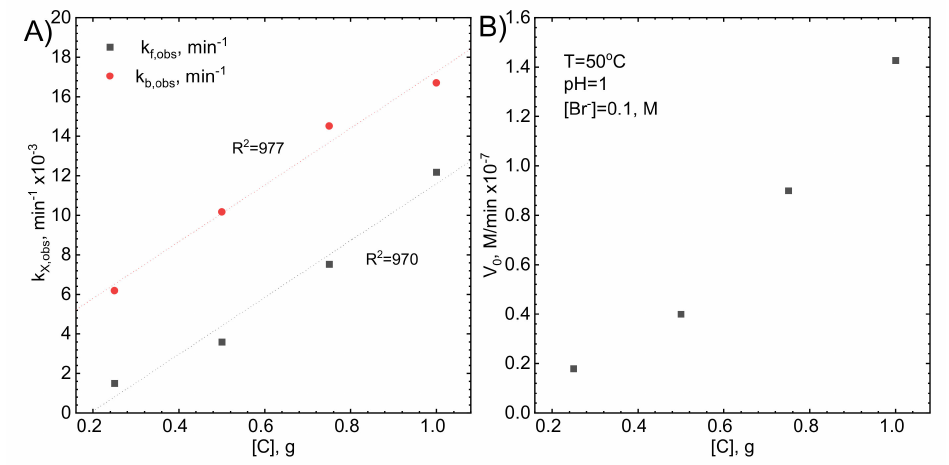
Figure 8. ( A ) the influence of the mass of activated carbon on the observed rate constants, ( B ) the influence of the mass of activated carbon on the initial rate, Experimental conditions: T = 50 ◦ C,